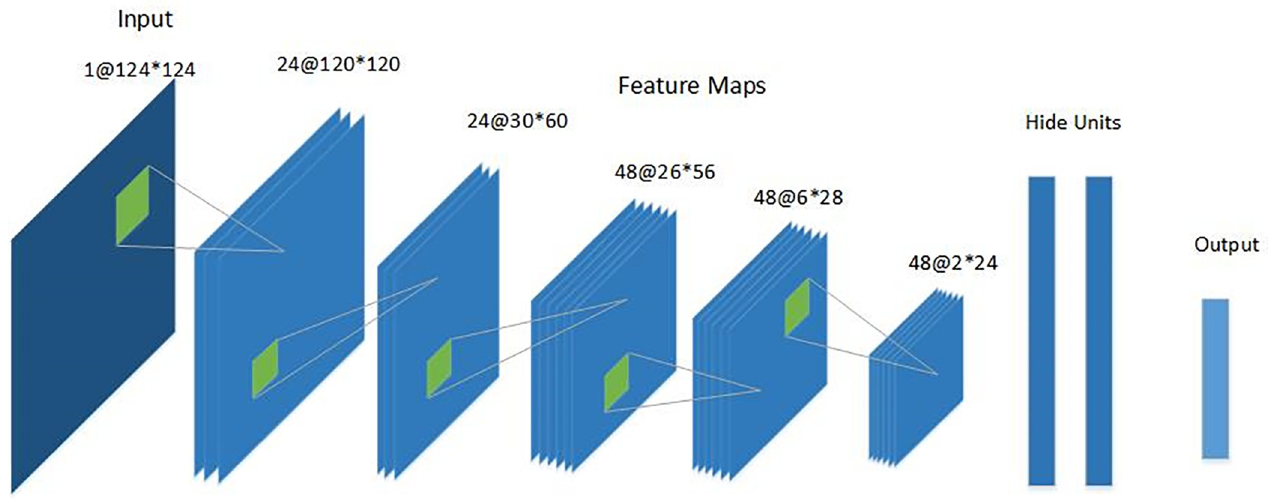
Fig 3. CNN model structure schematic